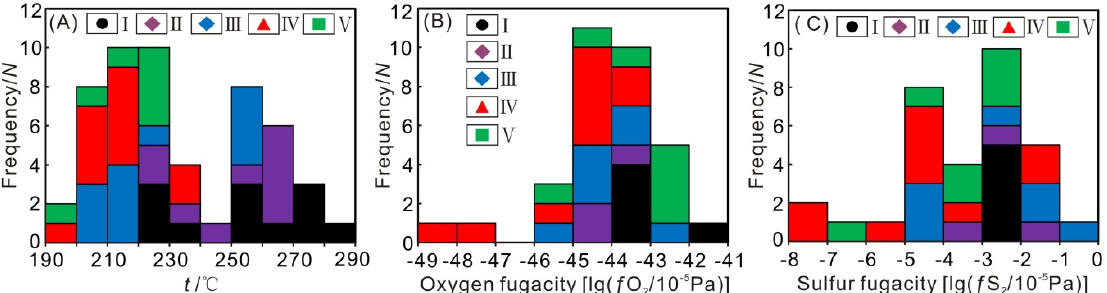
Figure 8. Histogram of formation temperatures, oxygen fugacity, and sulfur fugacity for chlorites from Huangsha uranium mining area. A —The formation temperatures frequency distribution histogram of chlorites. B —The formation oxygen fugacity frequency distribution histogram of chlorites. C —The formation sulfur fugacity frequency distribution histogram of chlorites. I—Chlorite from biotites, II—Chlorite closely associated with feldspar, III—Chlorite occurring in veins, IV—Uranium-associated chlorite, V—Chlorite transformed from clay minerals.